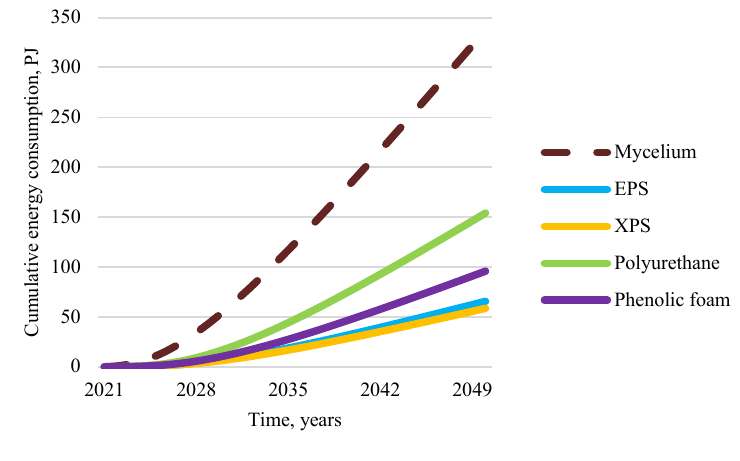
Fig. 4. Cumulative energy consumption from insulation material production.